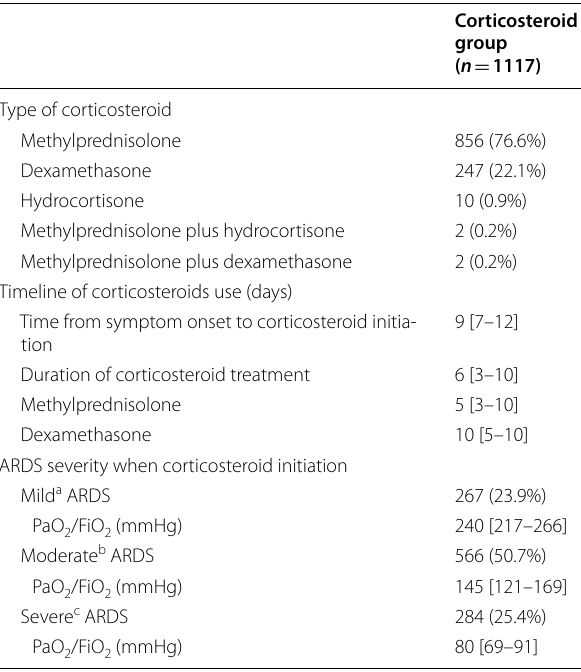
Table 2 Description of corticosteroid use for COVID‑19‑ associated acute respiratory distress syndrome